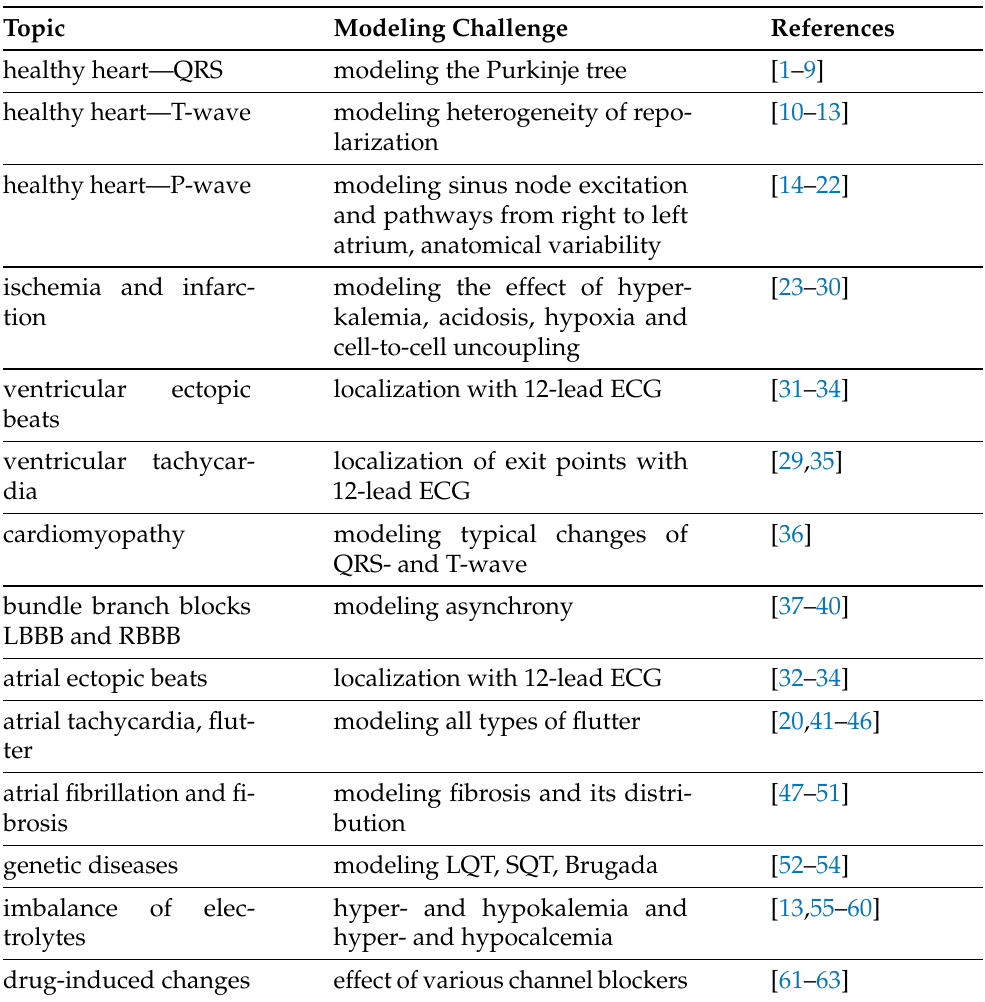
Table 1. Literature survey of research about modeling of the heart together with the correspond- ing